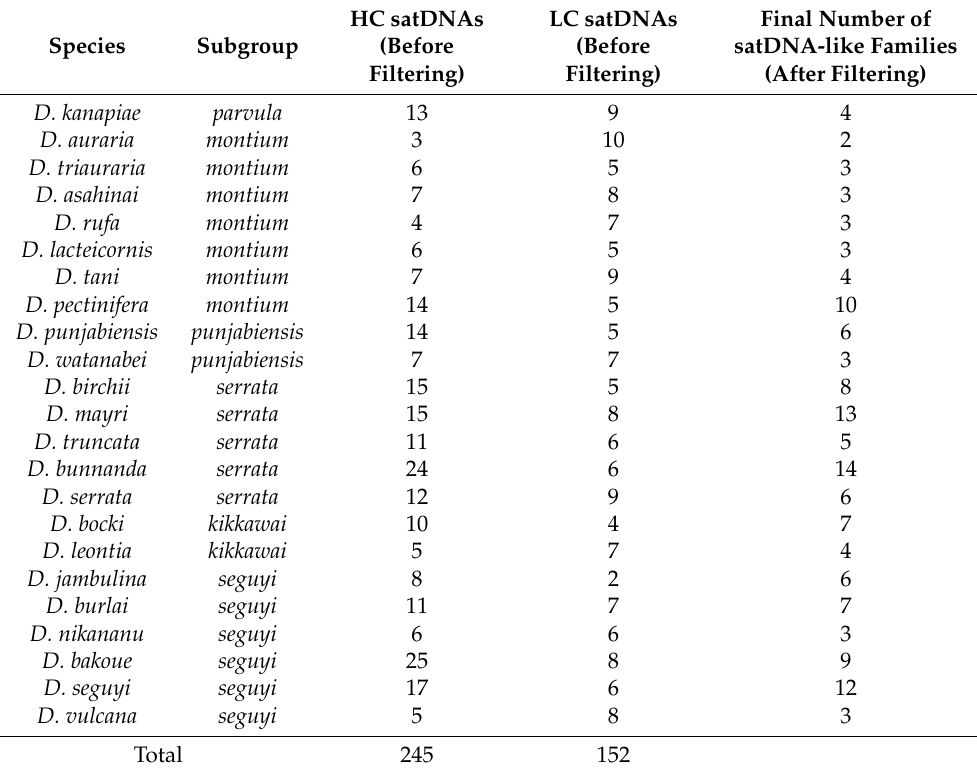
Table 1. SatDNA-like clusters identified in the montium group by TAREAN, before and after filtering. HC = High confidence; LC = Low confidence. Species Subgroup